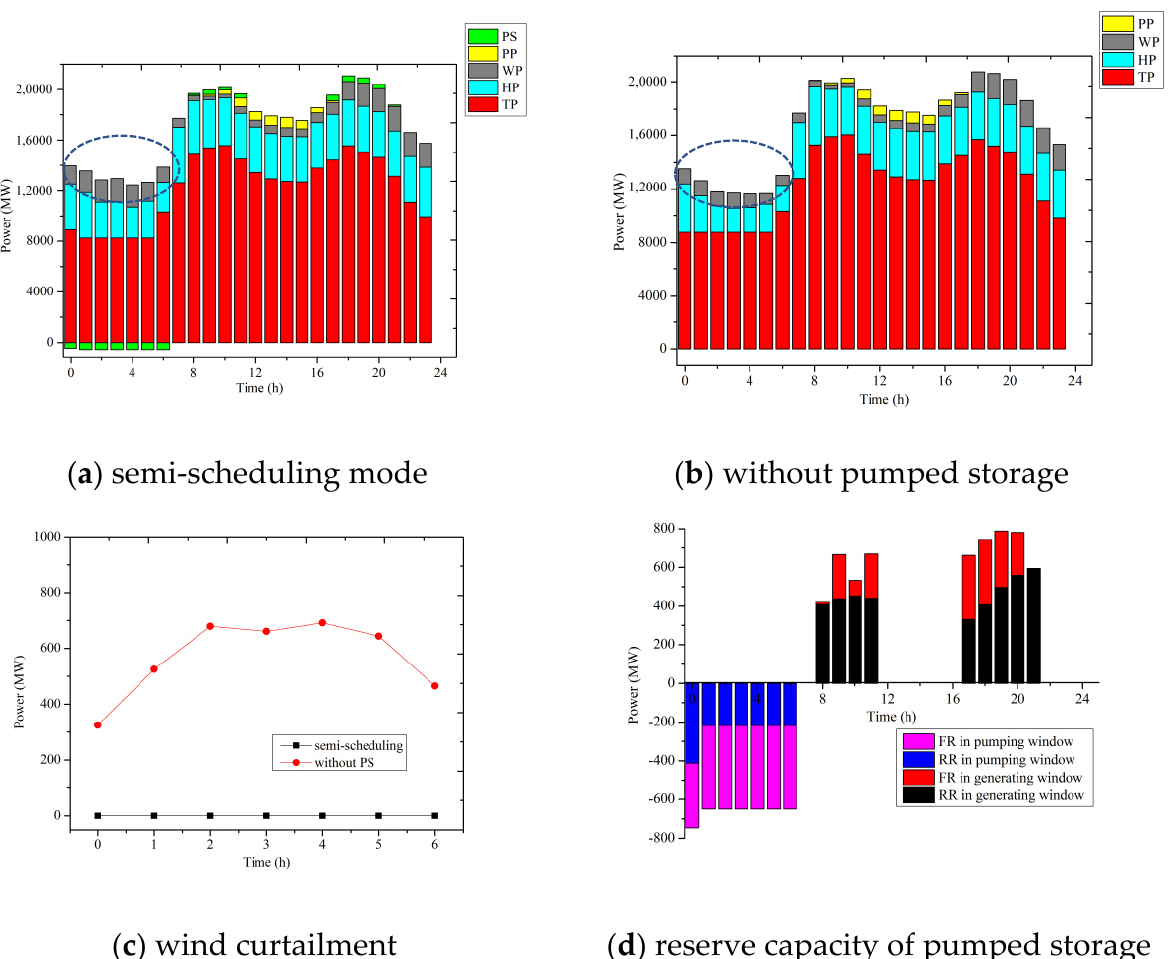
Figure 7. Scheduling results under semi-scheduling mode and scheduling mode without PS (PS means pumped storage, PP means PV power, WP means wind power, TP means thermal power, HP means hydropower, FR means frequency regulation and RR means rotating reserve).